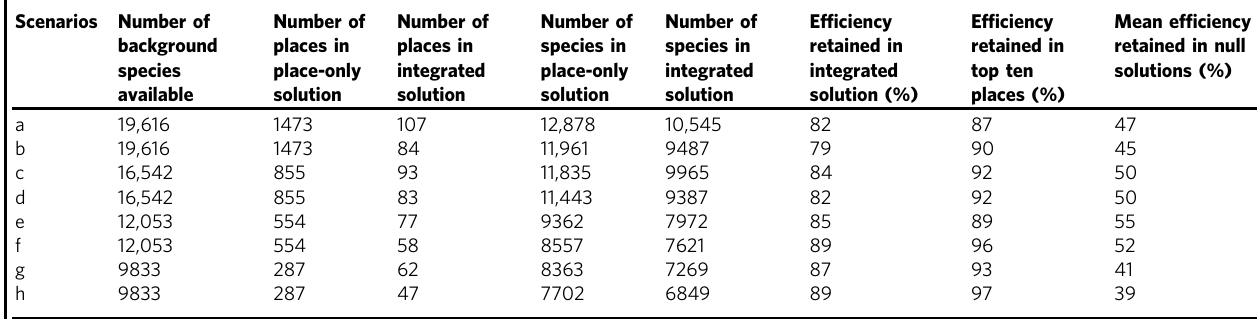
Table 1 Results from the place-only, integrated, and random approaches. Scenarios Number of background species